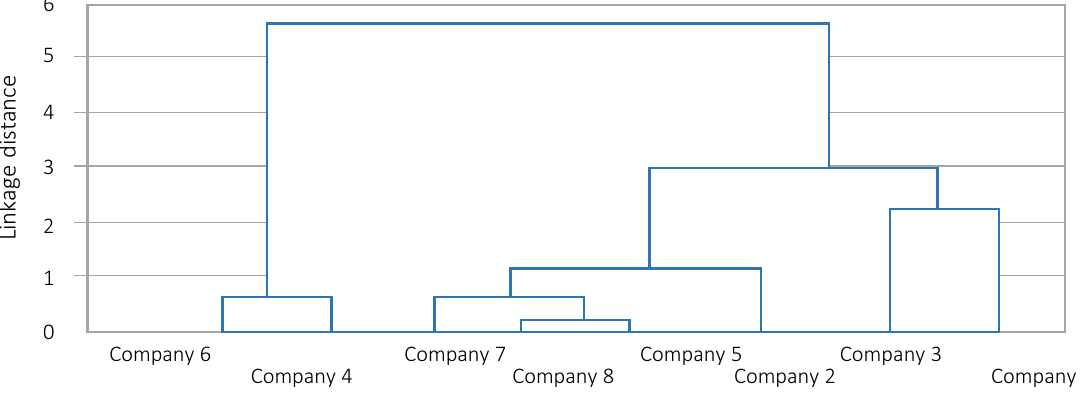
Figure 13. Hierarchical classification of shipping companies and